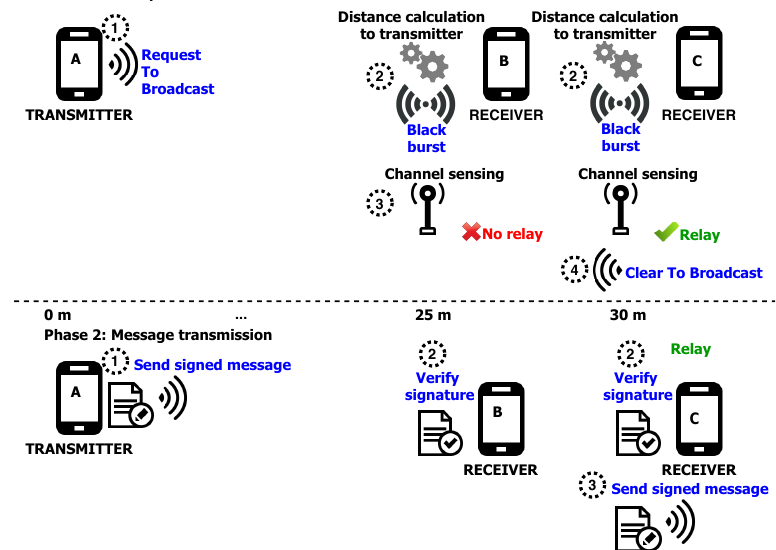
Figure 5. Relay node identification ( phase 1 ) and transmissions behavior ( phase 2 ) with the Urban Multi-hop Broadcast (UMB) message dissemination